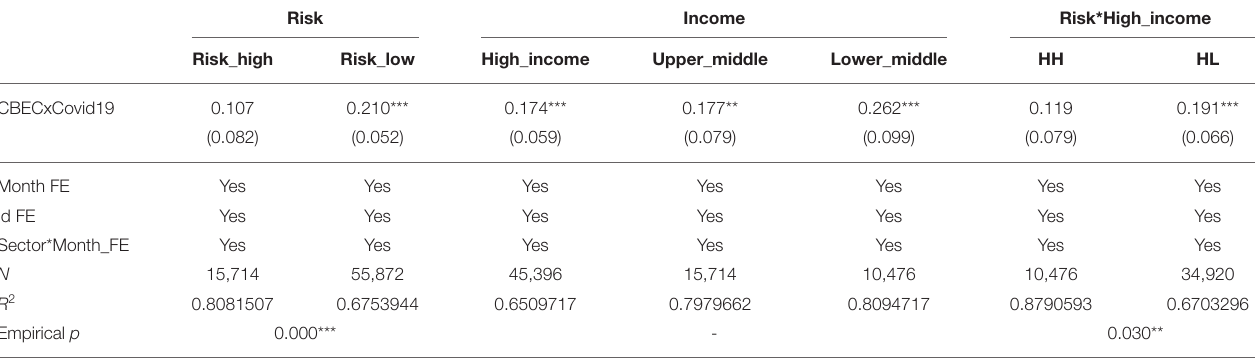
TABLE 7 | Regression results of the country/region heterogeneity